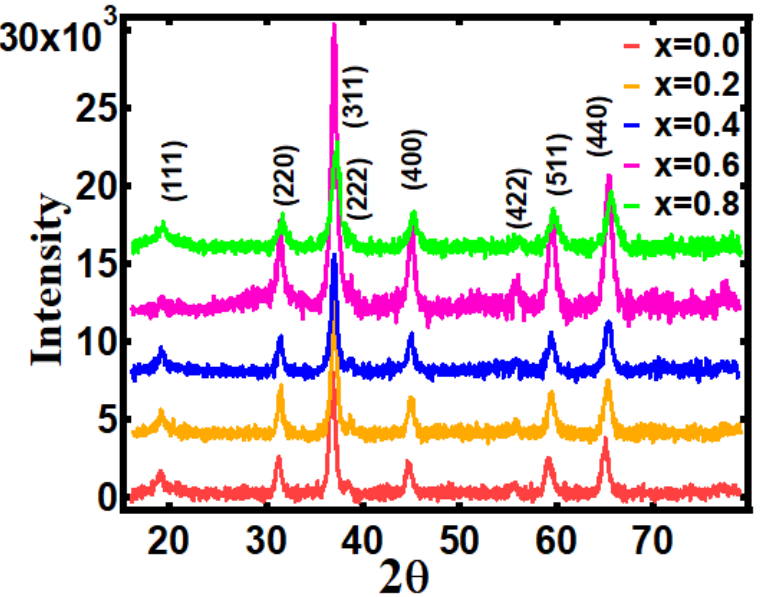
Figure 1. X-ray diffraction pattern for Ni 1-x Al x Co 2 O 4 . Table 2. Surface area parameters derived from the adsorption-desorption curve, crystallite size obtained using Scherrer’s formula, lattice parameter obtained from XRD refinement, and Al 3+ content was obtained from the XPS analysis of Ni 1- x Al x Co 2 O 4 compound.